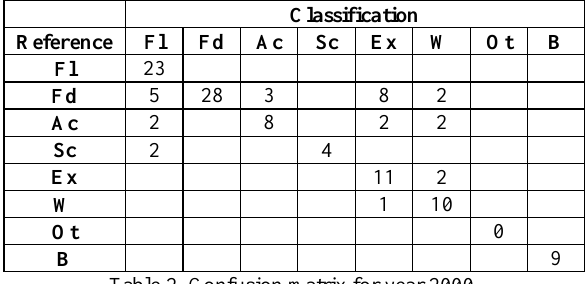
Table 2. Confusion matrix for year 2000.